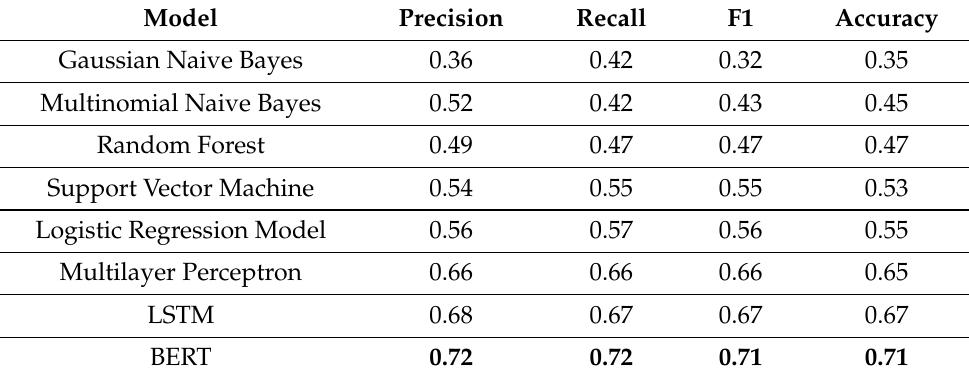
Table 2. Macro-averaged resulsts for each model. Best scores are in